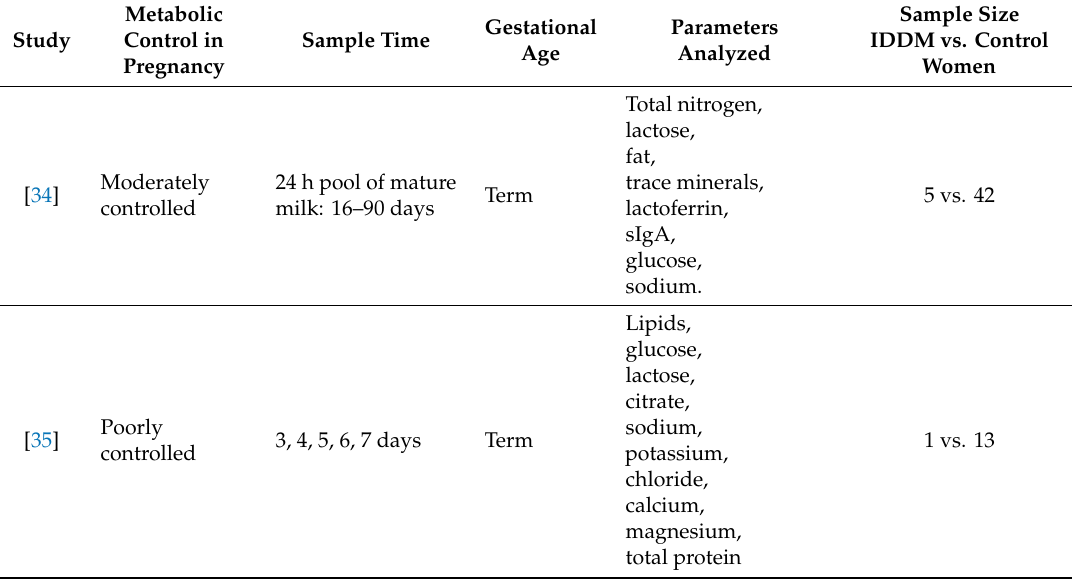
Materials and Methods of the di ff erent studies included in the survey regarding insulin-dependent diabetes mellitus (IDDM) and